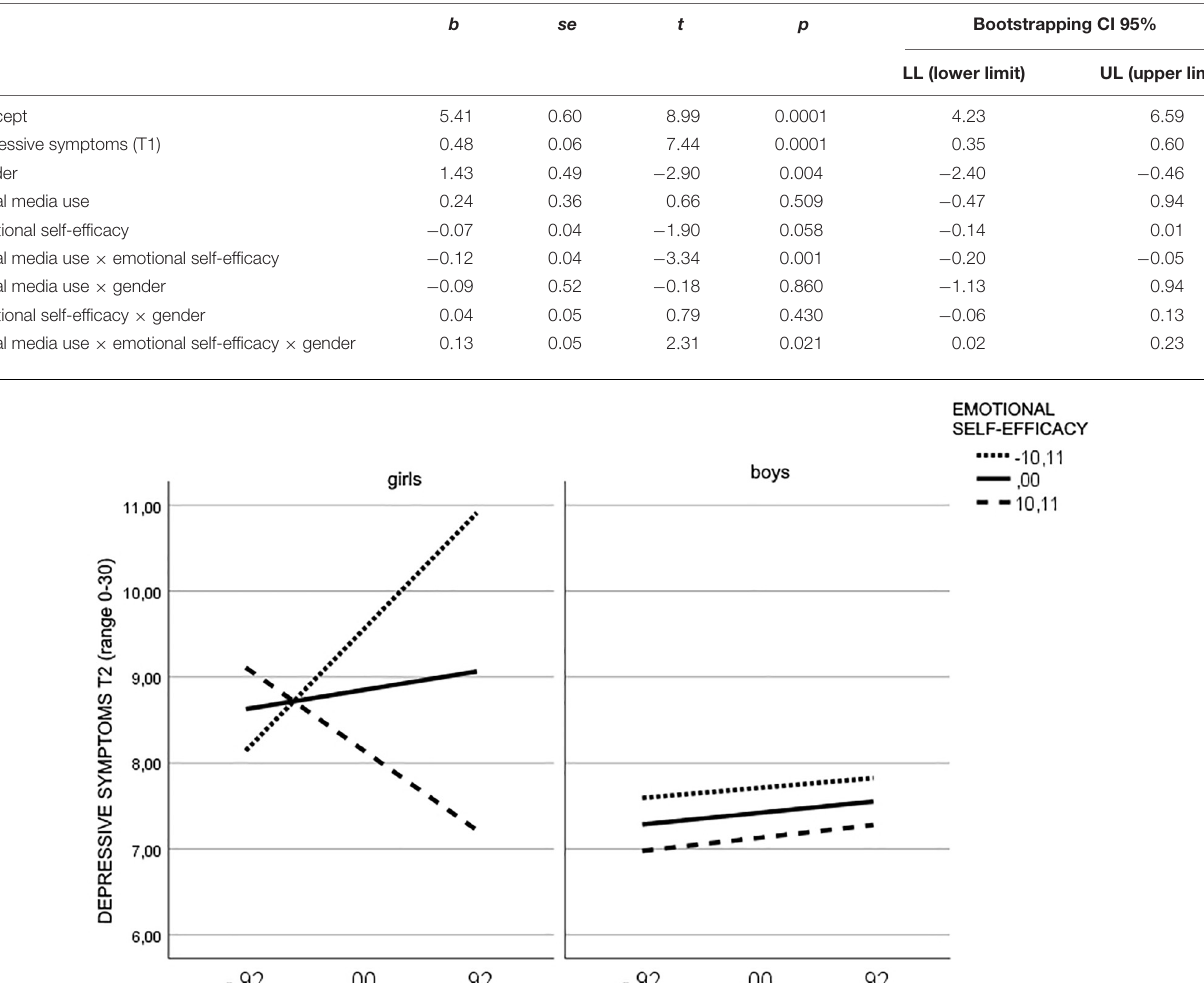
TABLE 3 | Predictors of depressive symptoms (T2) (regression analysis).